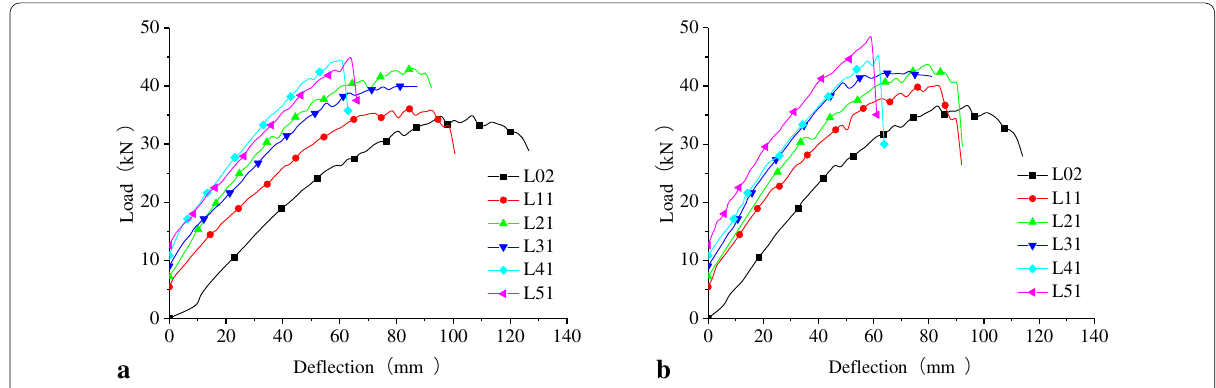
Fig. 11 Load–deflection curves of all the specimens. a Left span of specimens; b Right span of specimens